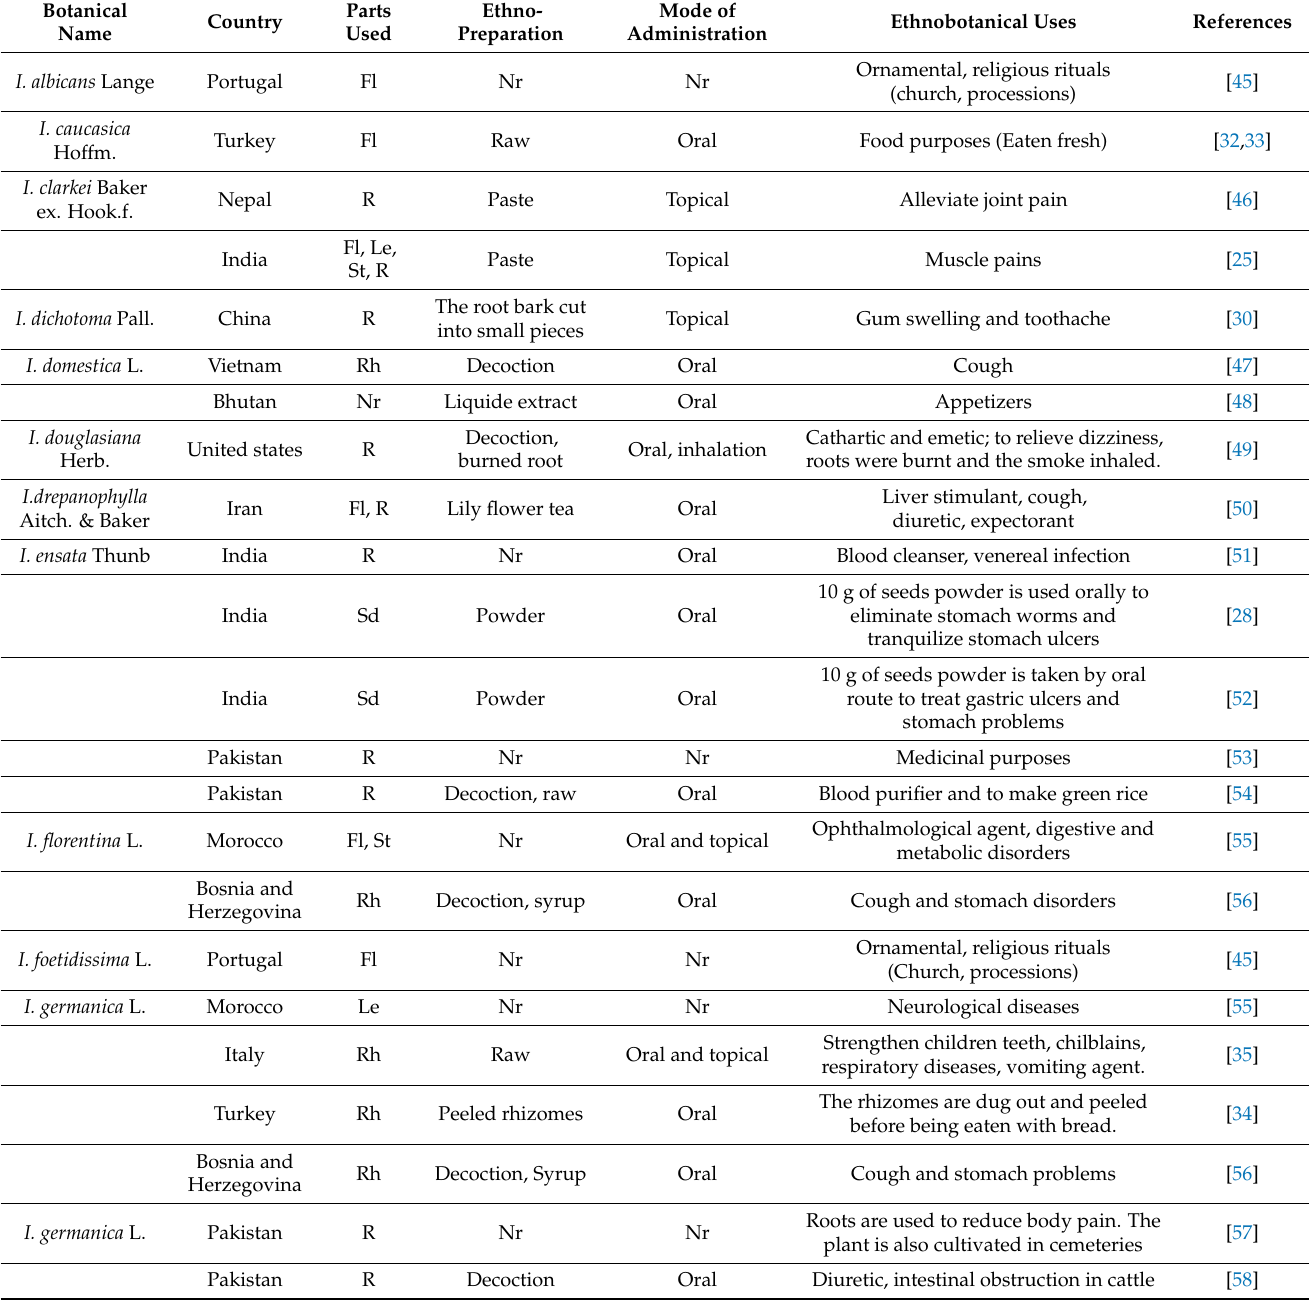
Table 2. Ethnobotanical uses of Iris spp., according to a plethora of ethnobotanical